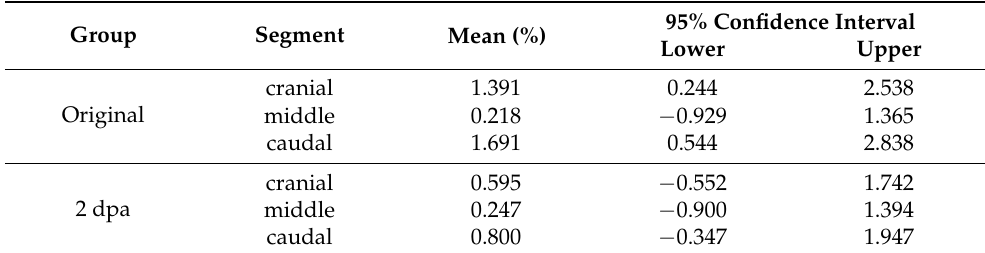
Table 4. Proportion of BrdU+ ependymal cells and 95% confidence intervals for the short-duration (2 day pulse, 0 day chase) experiment.